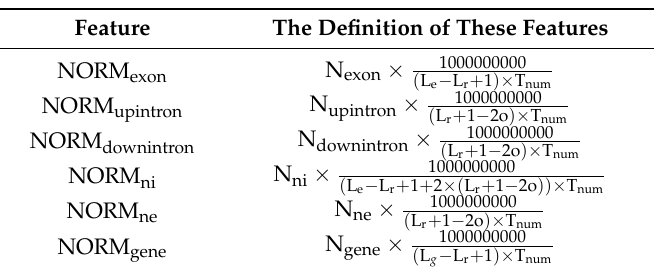
Table 8. The description of basic normalized